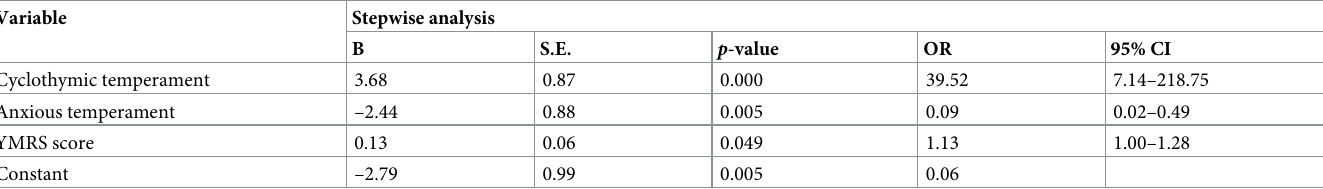
Table 2. Stepwise multivariate logistic regression analysis of the diagnosis of MDD and BD-I.